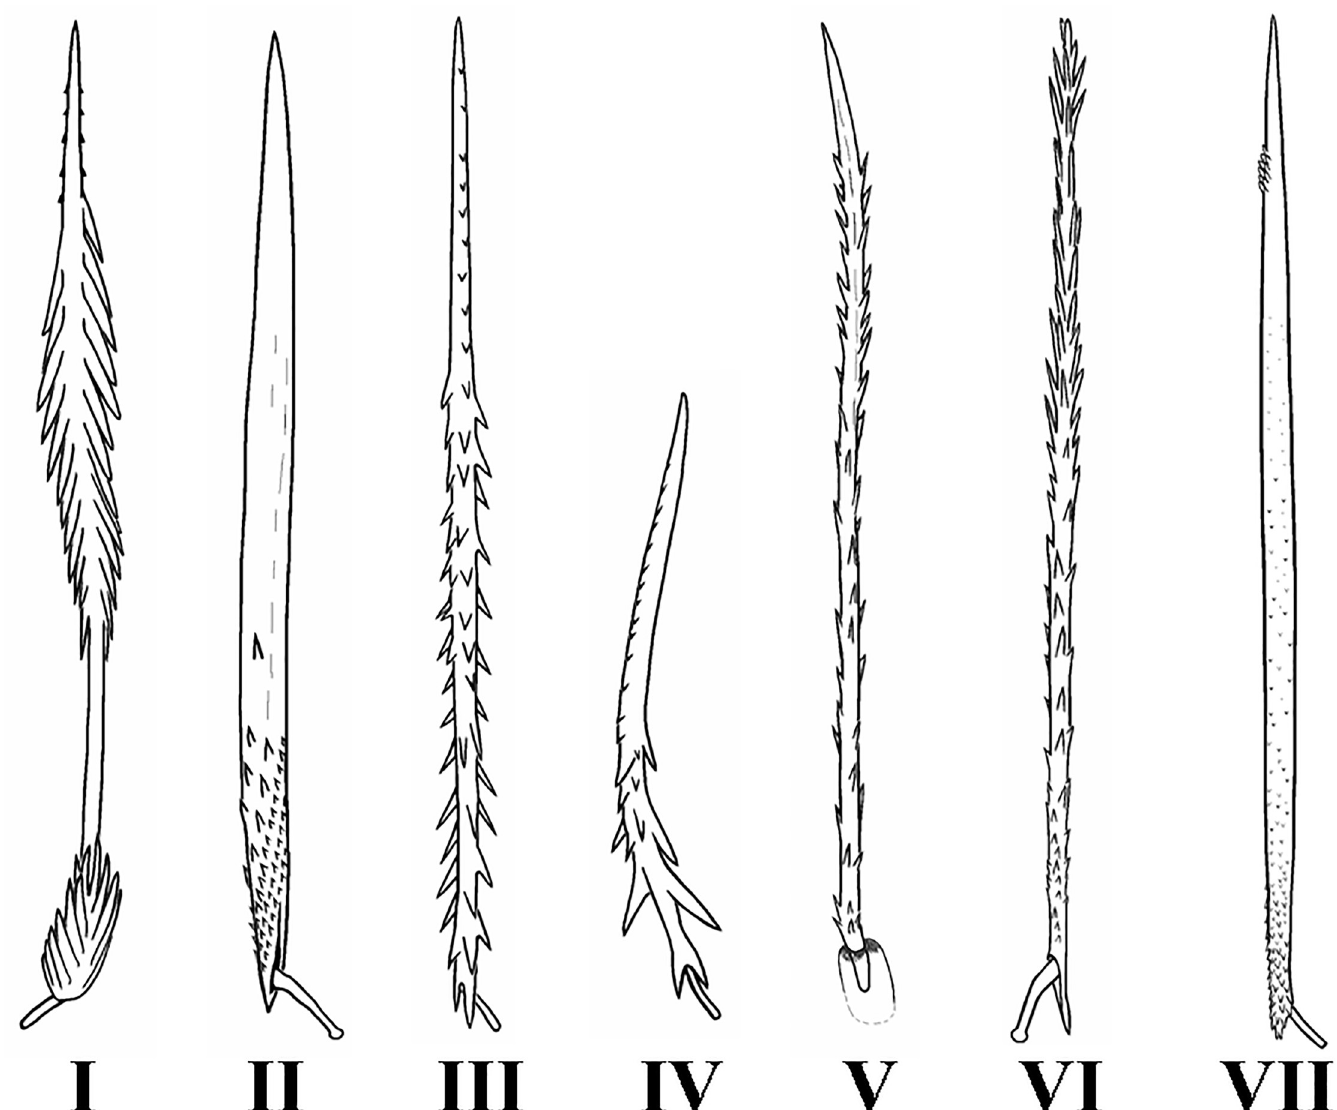
Fig 1. Abdominal urticating setae of types I, II, III, IV, VI and VII with their supporting stalks, and palpal urticating setae of the type V with the insertion socket.